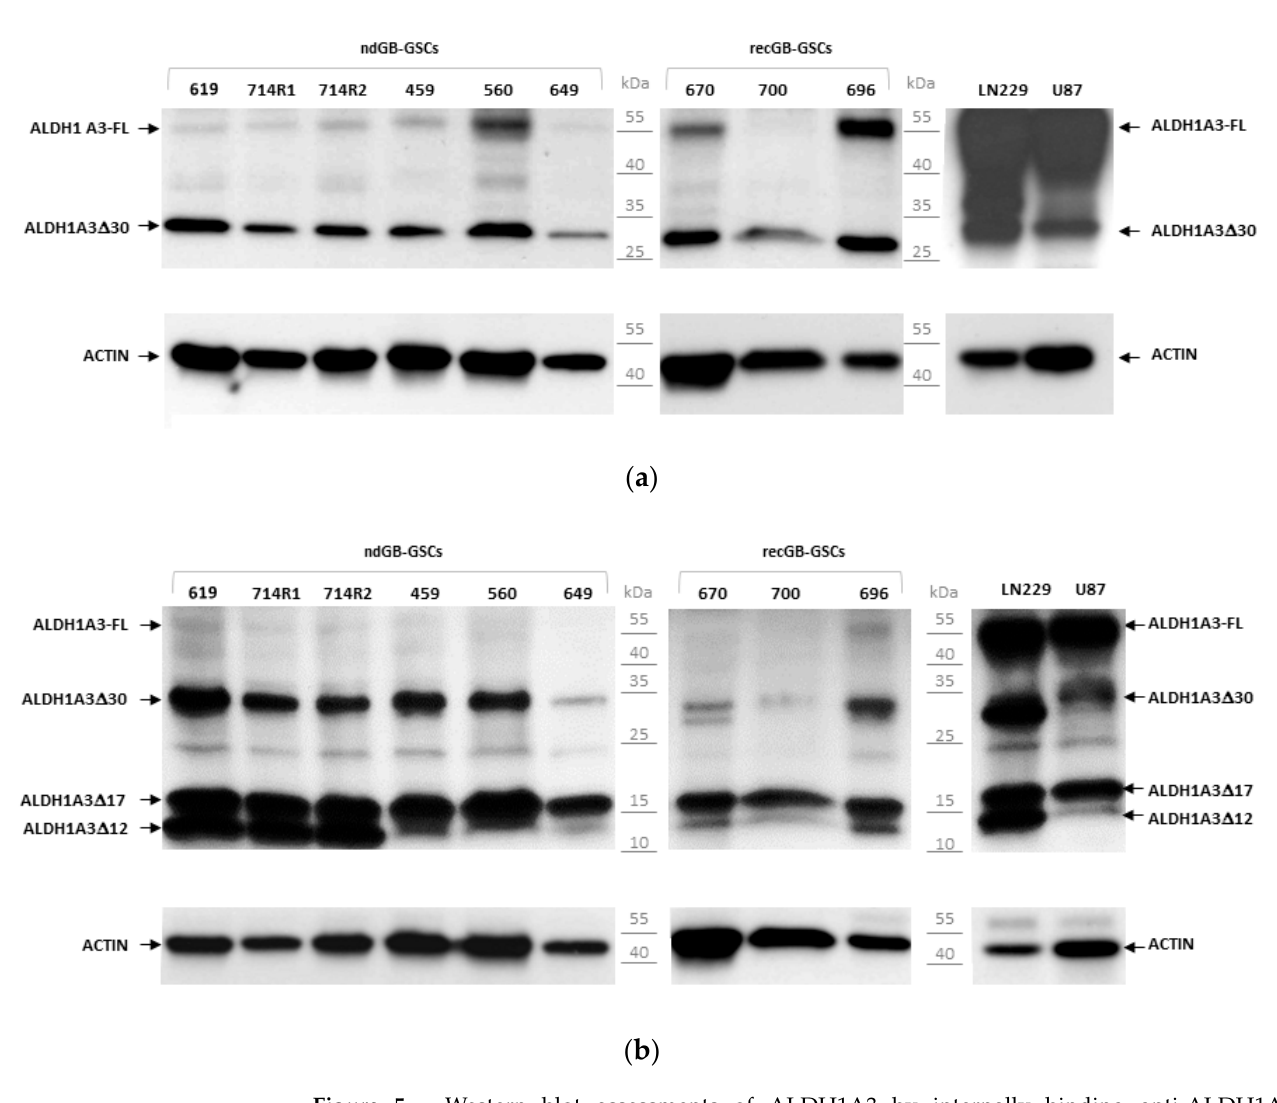
Figure 5. Western blot assessments of ALDH1A3 by internally binding anti-ALDH1A3 antibodies: ( a ) pattern revealed by antibody PA5-29188 (aa126-423); ( b ) pattern revealed by antibody ab129815 (aa100-200). The abundance of truncated ALDH1A3 proteins relative to the full-length ALDH1A3 (ALDH1A3-FL) is much greater in GSCs than in non-stem glioma cells U87 and LN229. As PA5-29188 antibody binds in the middle of ALDH1A3 (Figure S2), these results sug- gest that the 30 kDa peptide (termed provisionally as “ALDH1A3 ∆ 30 “) is lacking either the N- or C-terminal portion of ALDH1A3. The ALDH1A3 ∆ 30 peptide was also recognized by another anti-ALDH1A3 antibody, ab129815, which binds to the N-terminal region spanning 100–200 amino acid residues of the ALDH1A3 protein (Figure S2 and Figure 5b). Further- more, in addition to ALDH1A3 ∆ 30, ab129815 revealed two additional peptides migrating with the apparent molecular weight of 17 and 12 kDa (termed as ALDH1A3 ∆ 17, and ALDH1A3 ∆ 12, respectively, Figure 5b). Notably, although ALDH1A3 ∆ 30, ALDH1A3 ∆ 17 and ALDH1A3 ∆ 12 could also be detected in non-stem glioma lines LN229 and U87 (Figure 5), their proportions relatively to ALDH1A3-FL differed between GSCs and non- stem glioma cells. ALDH1A3-FL was found to prevail over truncated variants in non-stem glioma cells but not in GSCs, showing a clear predominance of truncated variants over the full-length protein (Figure